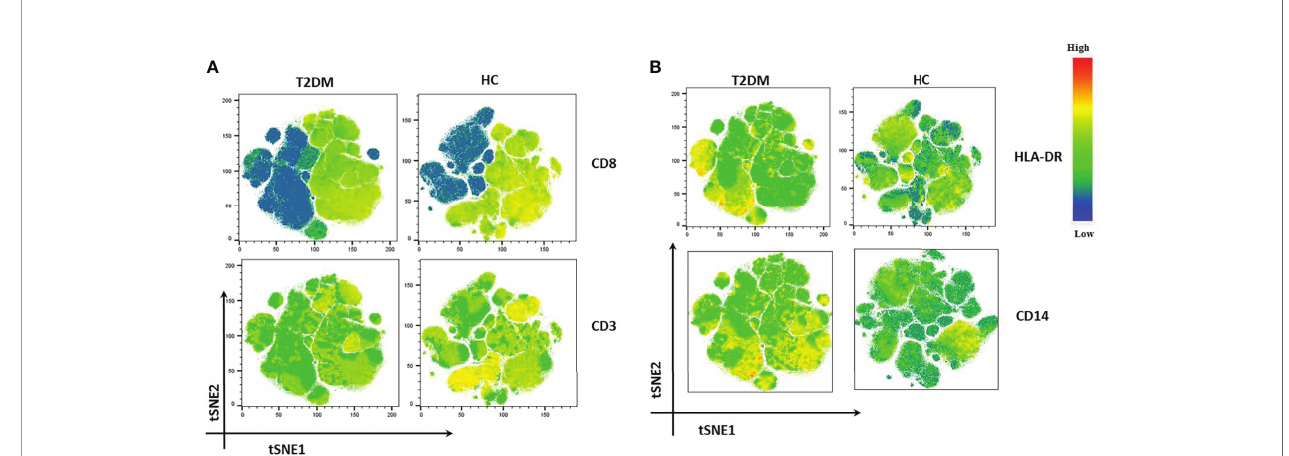
FIGURE 6 | t-SNE analysis of lowest and highest expressed markers in T2DM patients. (A) CD8 and CD3 showing decreased expression in T2DM patients. (B) HLA-DR and CD 14 showing increased expression in T2DM patients when compared to